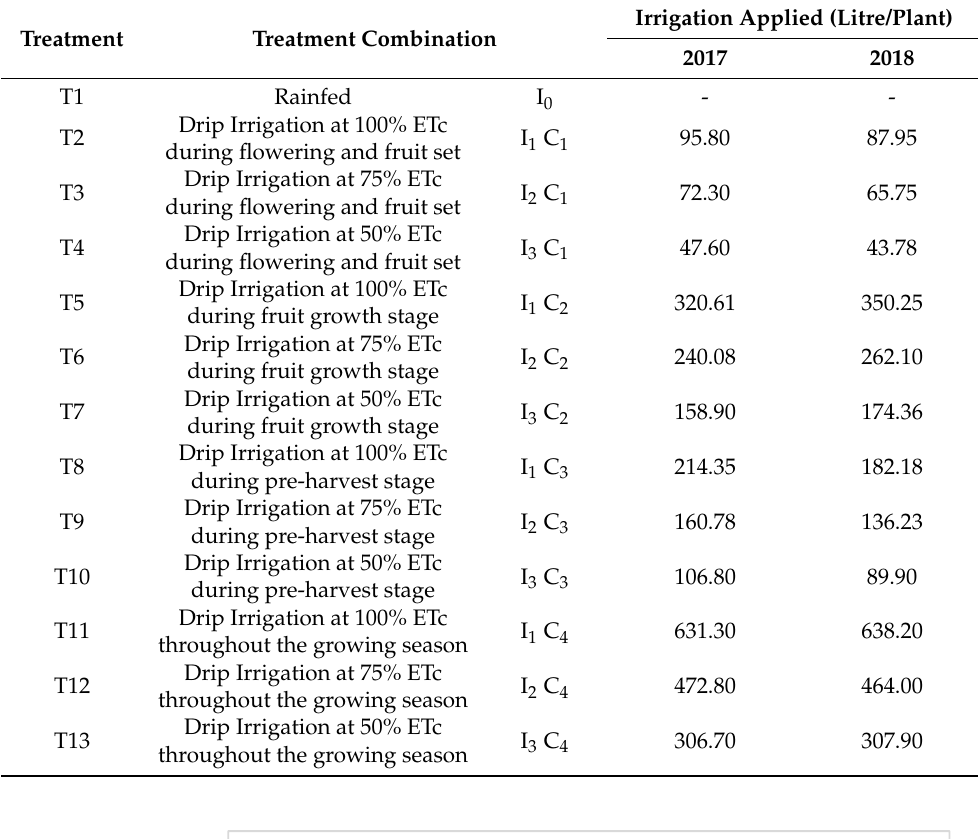
Table 2. Treatment combinations used in the experiment.